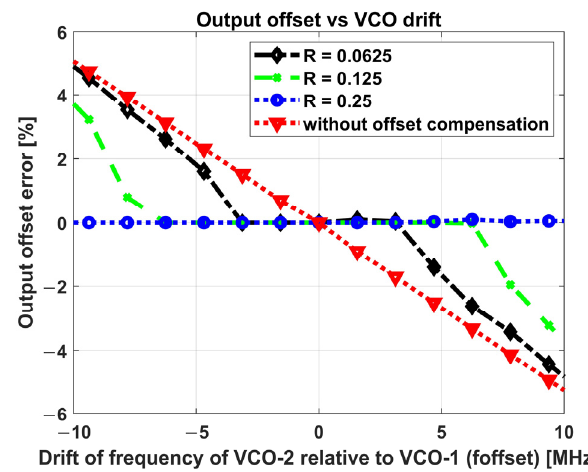
Figure 10. Variation in the measured fractional offset error of the output with the magnitude of maximum relative offset frequency of the two VCOs.